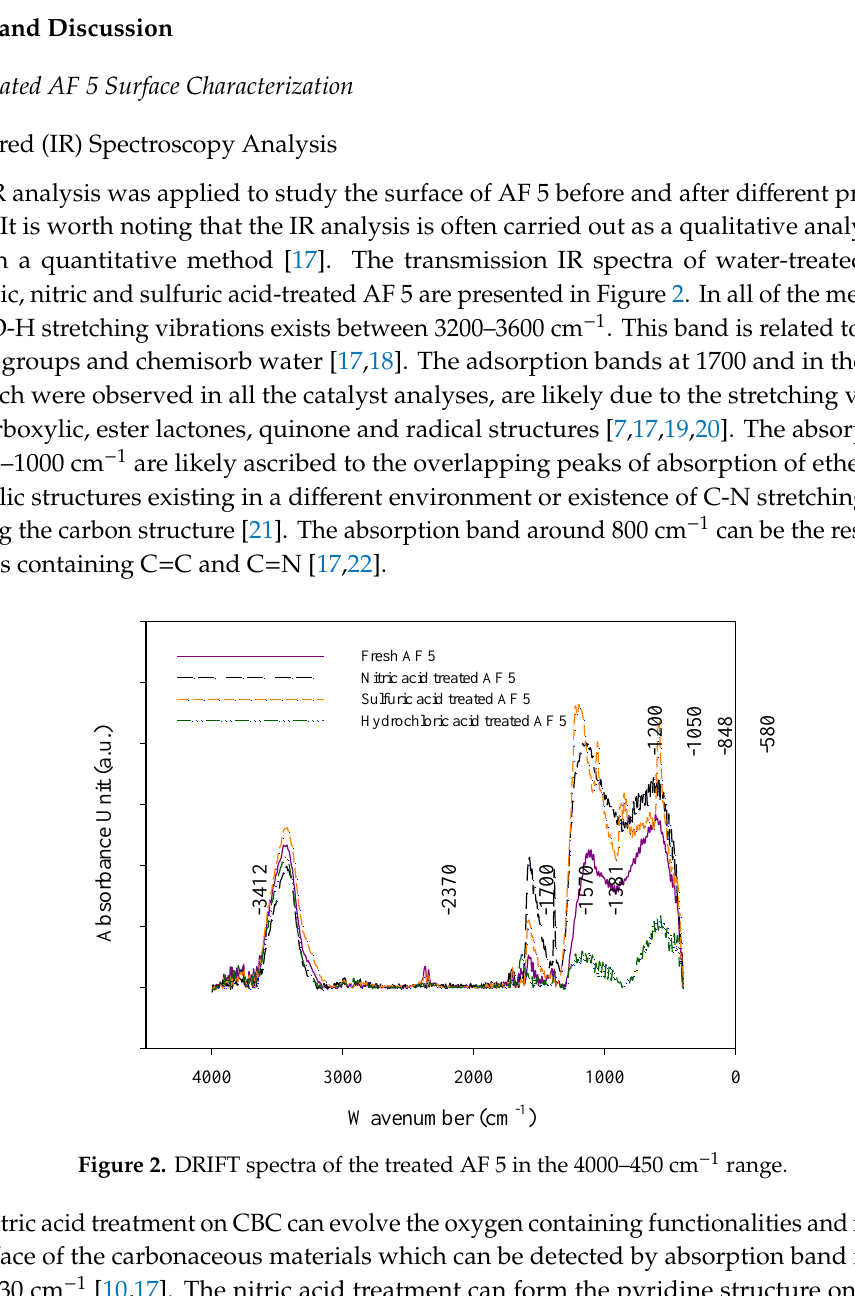
Figure 2. DRIFT spectra of the treated AF 5 in the 4000–450 cm −1 range.